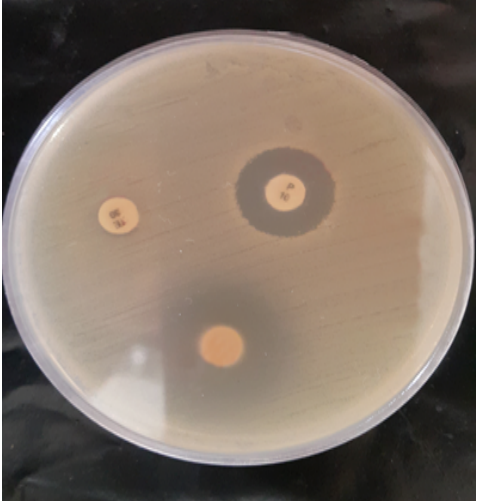
Figure 4. Growth inhibition zone of aqueous extract of Morus nigra , tetracycline and penicillin on Streptococcus pyogenes